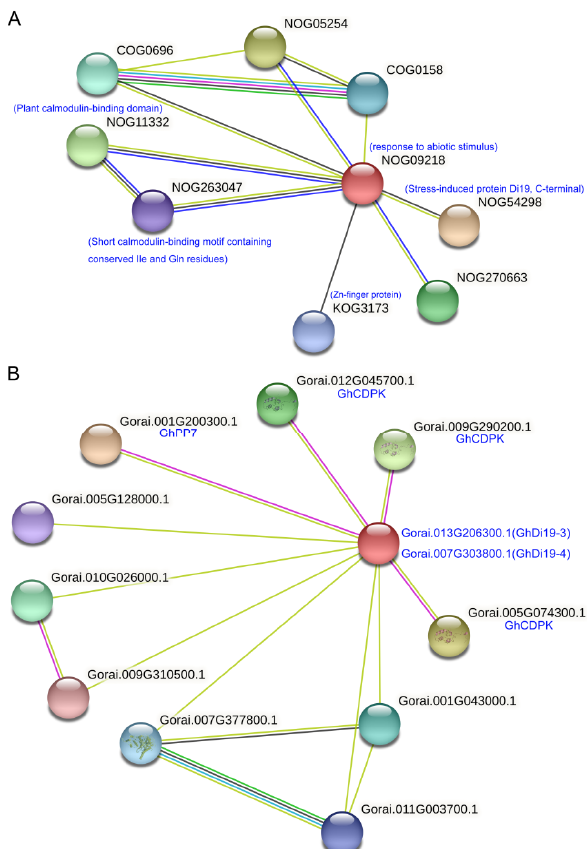
Figure 4. Association network of Di19s. ( A ) Association network of Di19 proteins. A total of nine association protein signaling pathways were identified. The blue letters represent Di19 protein signaling pathway or other protein families. ( B ) Association network of GhDi19-3 and GhDi19-4 with other Di19 proteins. A total of ten association proteins were identified. The blue letters represent CDPK proteins and other proteins.